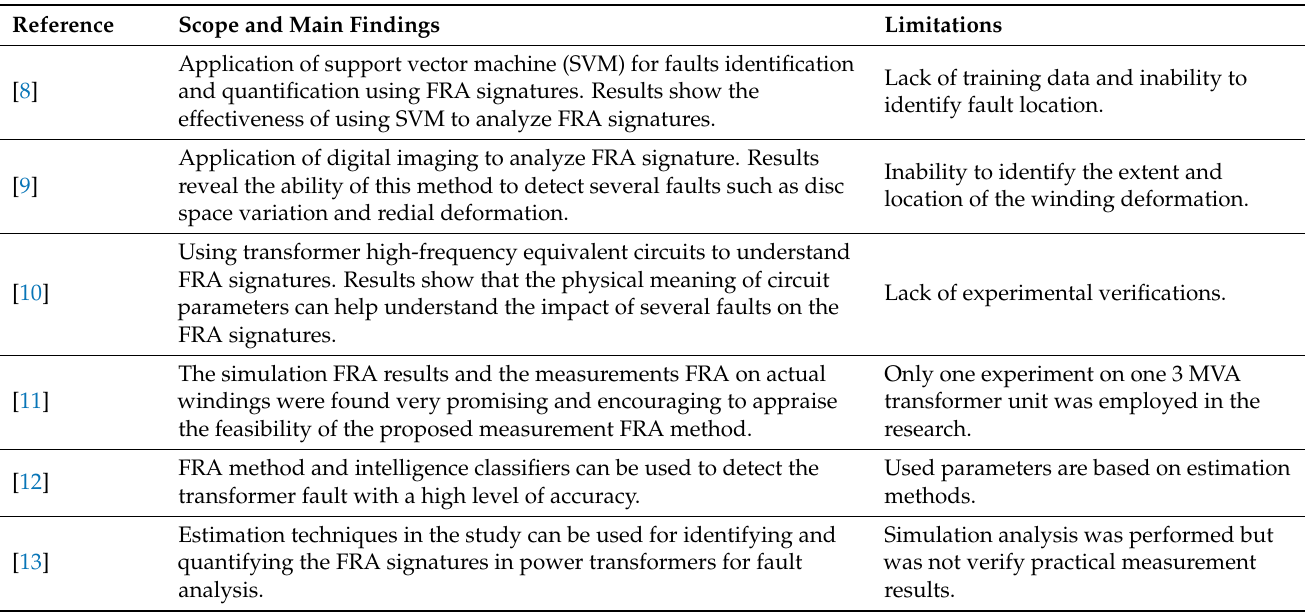
Table 3. Research published on the application of FRA on power